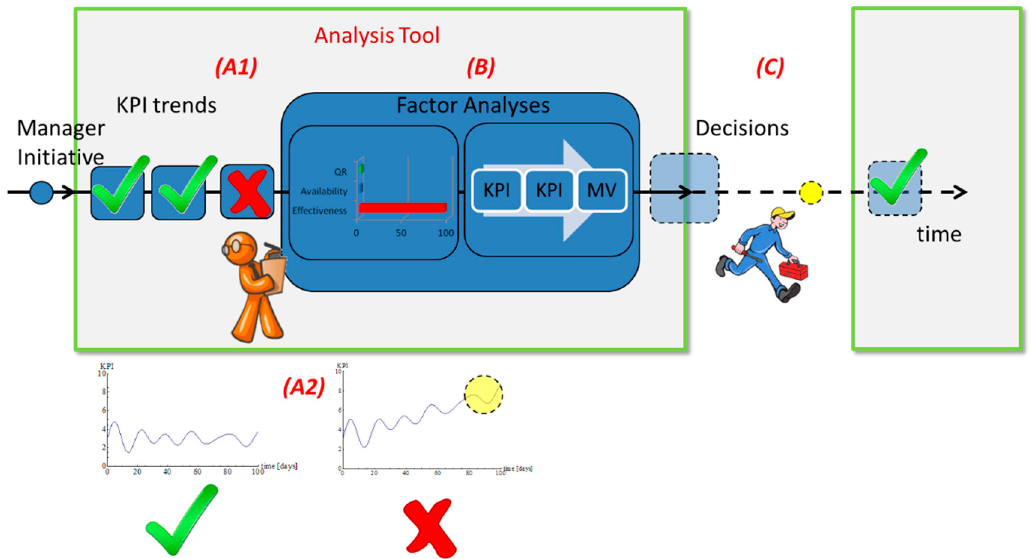
Figure 2. Schematic of the way the tool is run in real production.